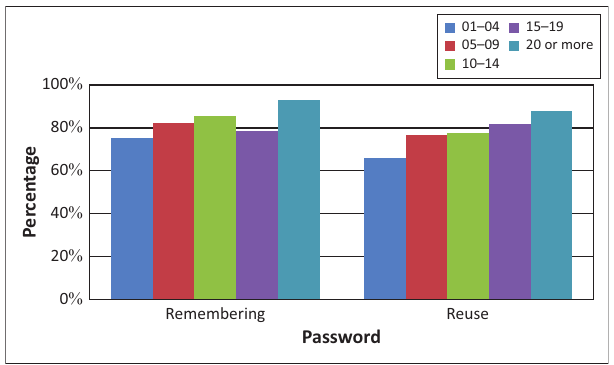
FIGURE 8: Problems remembering passwords and password reuse increase with the number of Internet sites accessed.